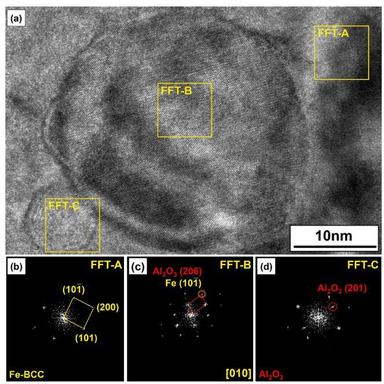
(a) HRTEM images of a typical Al–O dispersoid obtained along the crystal band axis of the matrix Fe. (b) FFT patterns in region FFT-A, (c) FFT patterns in region FFT–B, and (d) FFT patterns in region FFT–C.